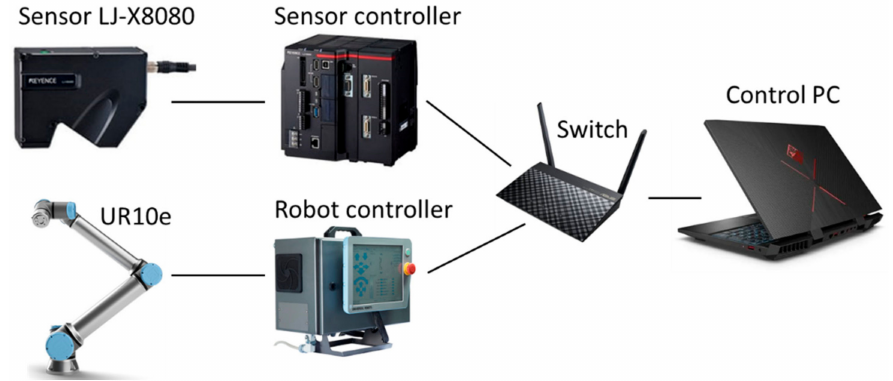
Figure 6. Communication diagram of the workplace.